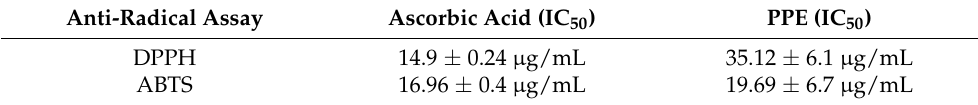
Values are mean ± SD, n =